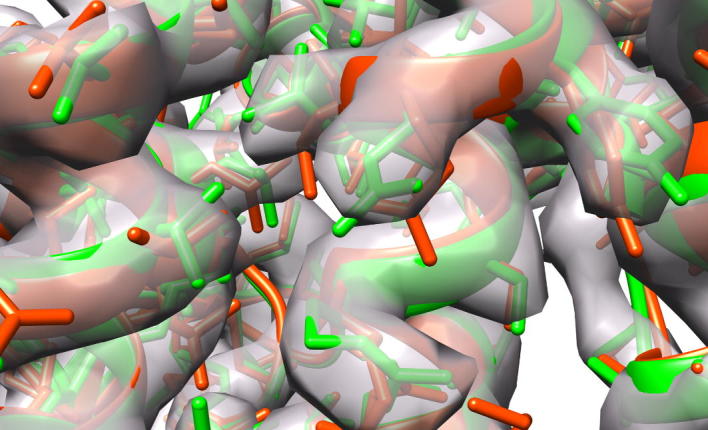
Flexible fitting of ADP-bound GroEL (PDB: 4KI8) to raw and sharpened density maps corresponding to the unliganded form of GroEL solved at 3.3 Å resolution. Comparison of side-chains in a small region of the model refined on the sharpened map (green) with those of the model refined on the raw density (orange). The sharpened map density in shown in transparent grey.